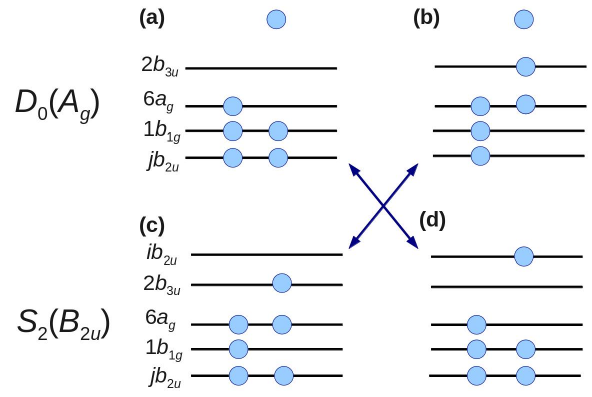
Figure 6. Electronic configurations of D are shown in ( a , c ), respectively. By two-electron excitation, configurations ( b , d ) are obtained from configurations ( a , c ), respectively. Arrows indicate the allowed transition by one-photon ionization. Filled circles represent electrons. Isolated electrons at the top of panels ( a , b ) represent